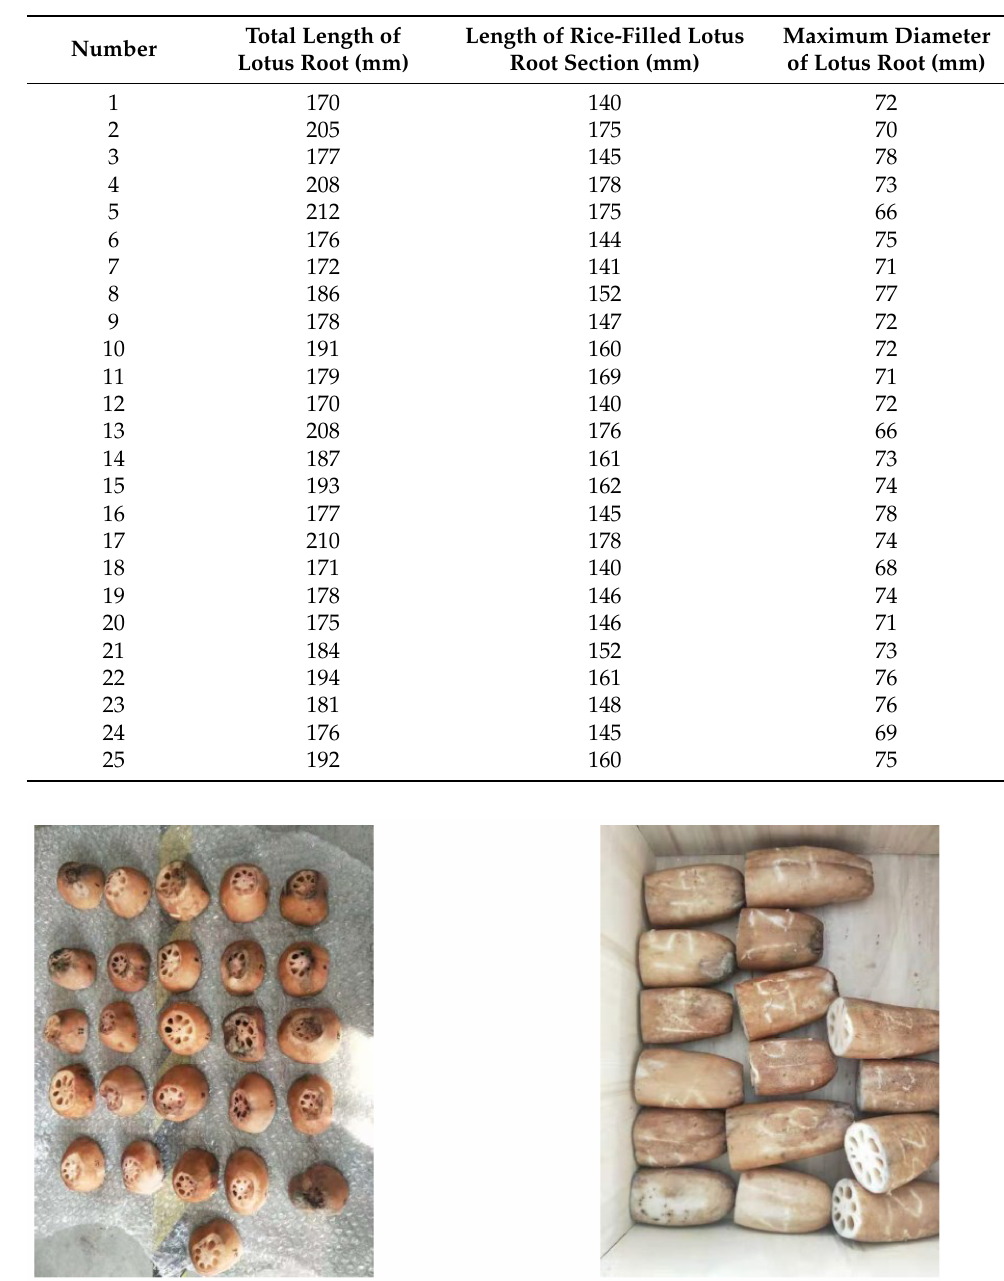
Table 3. Size of lotus root sections.